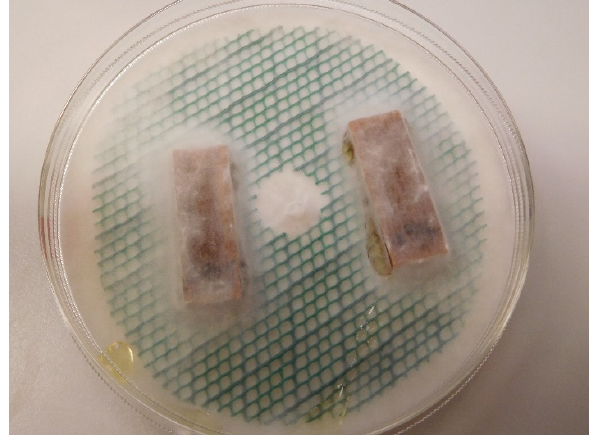
Figure 7. SCA56 modified samples incubated with Rhodonia placenta for eight weeks.